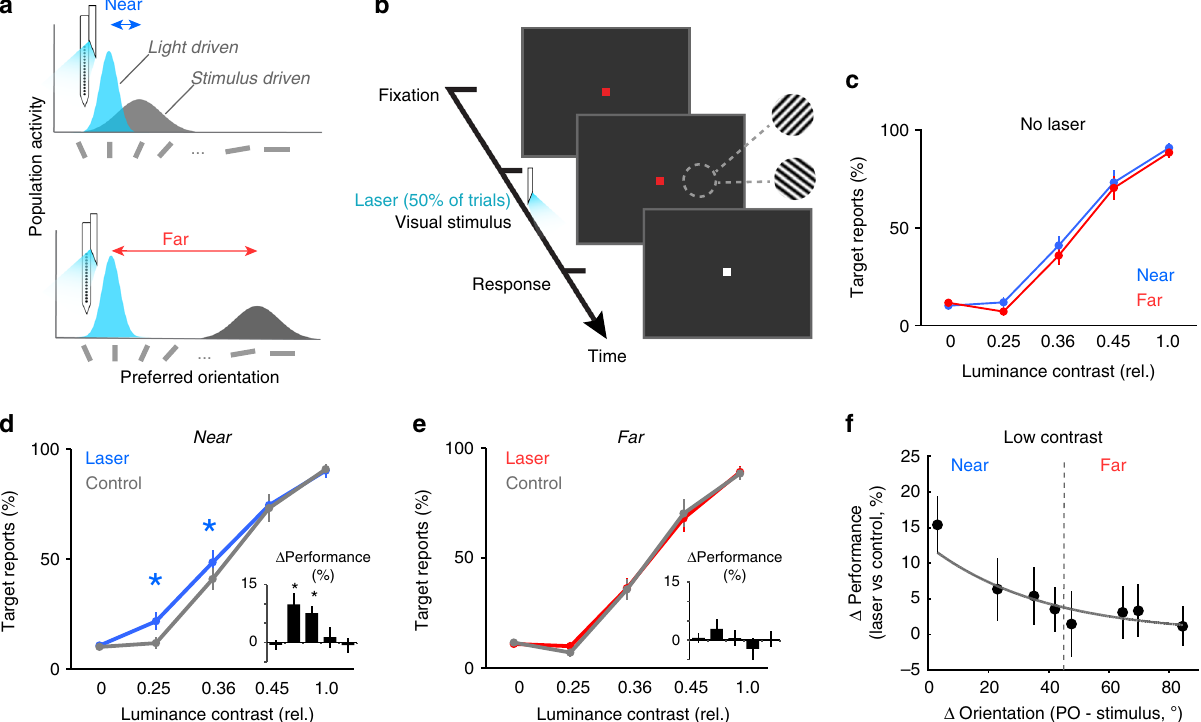
Fig. 2 Stimulus detection performance increases when the stimulated neural populations are nearby. a Cartoon showing how two neural populations can be simultaneously activated using light and visual stimulation. The functional distance between the two populations is controlled by changing the orientation of the visual stimulus to be “ near ” (upper) or “ far ” (lower) from the preferred orientation of the light-driven population. b Detection task design. Following a fi xation period, oriented gratings are presented at four different contrasts. Half of trials contain no visual stimulus, and half of the trials are paired with optical stimulation. All contrasts and orientations are randomly interleaved. Monkeys are cued to report the presence or absence of a stimulus. c In the control (no laser) condition, detection performance for “ near ” and “ far ” stimulus orientations is similar for all contrast levels ( P > 0.50 all contrasts, Wilcoxon signed rank tests). Error bars show s.e.m. d , e Percent target reports across sessions. Optogenetic stimulation-induced change in behavioral performance when the neural population is exposed to the “ near ” ( d ) and “ far ” stimulus ( e ). Optogenetic stimulation improves the detection of the two lowest contrast stimuli in the “ near ” condition (* P = 0.0025, Kruskal – Wallis test, df = 4, Chi-squared value = 16.43, post hoc Wilcoxon signed rank test), but had no impact in the “ far ” condition ( e ). Error bars show s.e.m. across sessions. f The light-induced enhancement in behavioral performance decays as the orientation difference between the two subpopulations increases. Black dots represent the mean change in target reports (laser vs. control) across sessions according to the orientation difference between the visual stimulus and the preferred orientation of the light-activated population (Sessions were grouped into 10° increments. Vertical dashed line shows the division between “ near ” and “ far ” categories. Fit is exponential. Error bars show (Fig. 2a). Animals performed a contrast detection task in which ( “ far ” condition, Fig. 2a lower) to the mean preferred orienta- they reported the presence or absence of a stimulus regardless tion (PO) of recorded, light-driven neurons, with the cutoff of its orientation (Fig. 2b, see Methods). Stimuli of varying criteria between conditions set to 45°. Figure 3a (left) shows a contrasts were present on 50% of trials. Optogenetic stimula- typical tuning curve for one example unit illustrating “ near ” tion was also present on 50% of trials. To maximize the stimuli presented close to the peak of the tuning curve, and “ far ” stimuli presented at an orthogonal orientation. Across potential impact of the light-evoked spikes, we chose stimulus contrasts that would minimally drive neurons, while providing sessions (Fig. 3a, right), the mean “ near ” orientation difference clear psychometric results in each animal. Stimuli consisted of ( Δθ ) between the population PO and stimulus orientation was luminance-varying contrast gratings, 2 – 3 deg in diameter, dis- 26.6° ± 2.9° s.e.m. (29 sessions), while the mean Δθ for the “ far ” played for 800 or 1300 ms on a dark screen, randomly inter- condition was 65.6° ± 2.7° s.e.m. (27 sessions). Orientation leaved with ‘ catch ’ trials (no stimulus). Laser pulses were synchronized and limited to the onset of the visual stimulus.